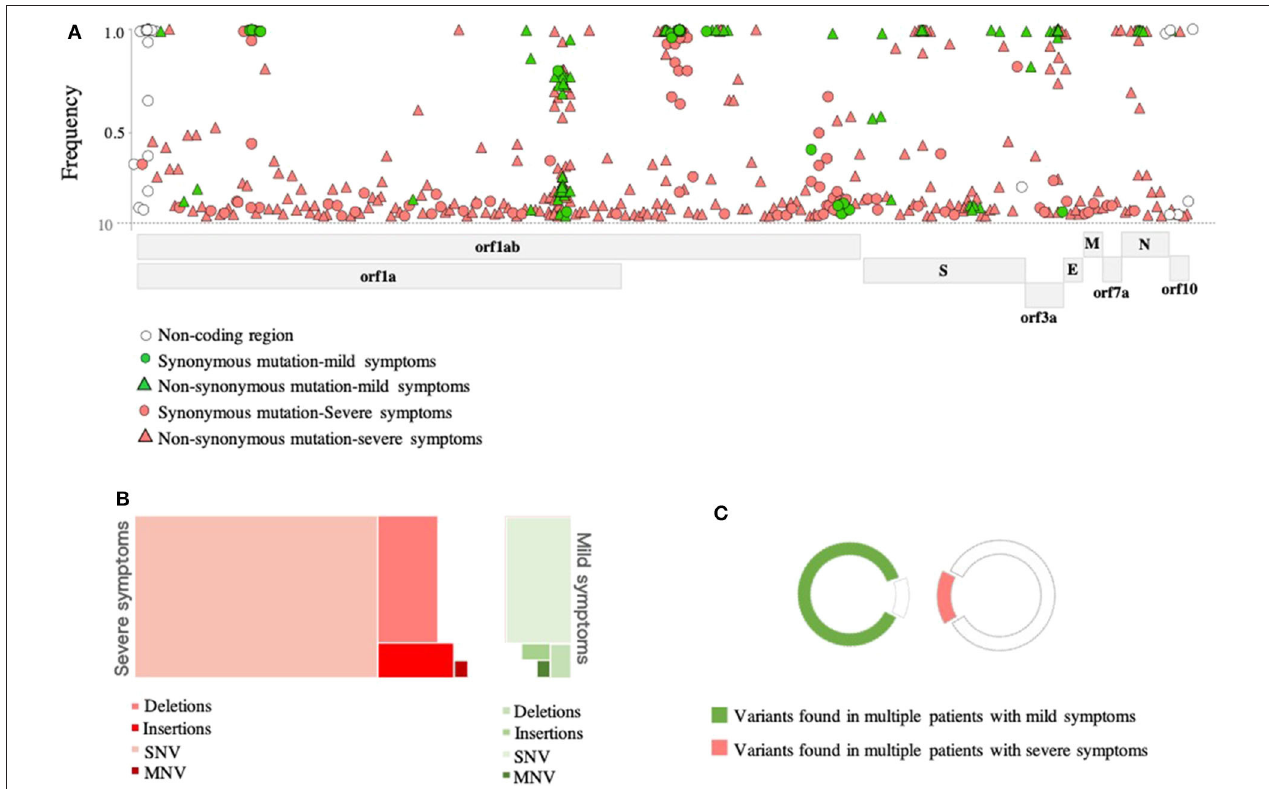
FIGURE 2 | Genomic variations detected in SARS-CoV-2 viruses. (A) Genomic positions and frequencies of variants found in the SARS-CoV-2 genome (55-29640) of 46 patients. The y-axis represents the frequency of variants, and the x-axis represents the genomic position of variants. (B) A tree map presenting types of variants found in SARS-CoV-2 genomes of mild (green) and severe (red) cases. (C) Colored parts of the circles represent variants seen in more than one